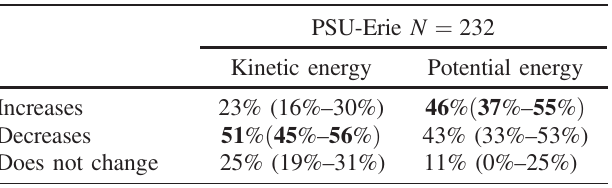
TABLE II: Student responses to the orbit problem. Correct responses are printed in bold. Values given are the mean across five sections. Values in parentheses reflect the 95% confidence interval based on variances among these